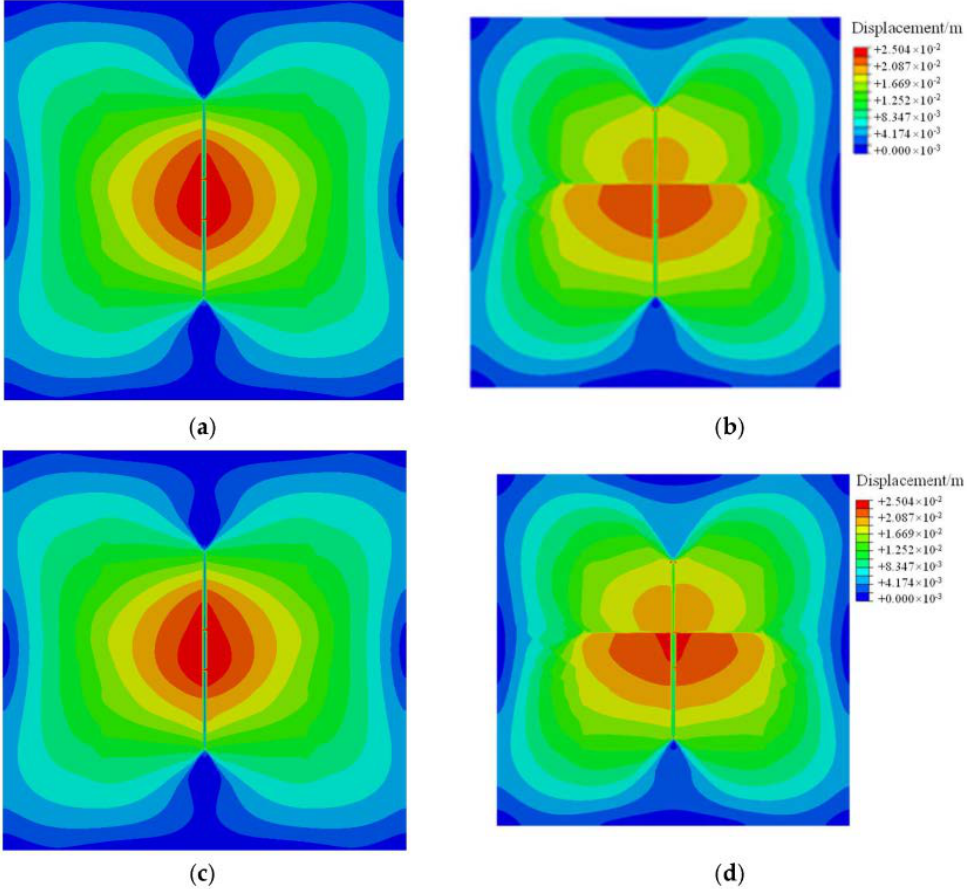
Figure 16. Cloud picture of displacement field under different stress contrast levels: ( a ) stress contrast of 6 MPa, time t = 55 s; ( b ) stress contrast of 6 Mpa, time t = 100 s; ( c ) stress contrast of 8 Mpa, time t = 55 s; and ( d ) stress contrast of 8 Mpa, time t = 100